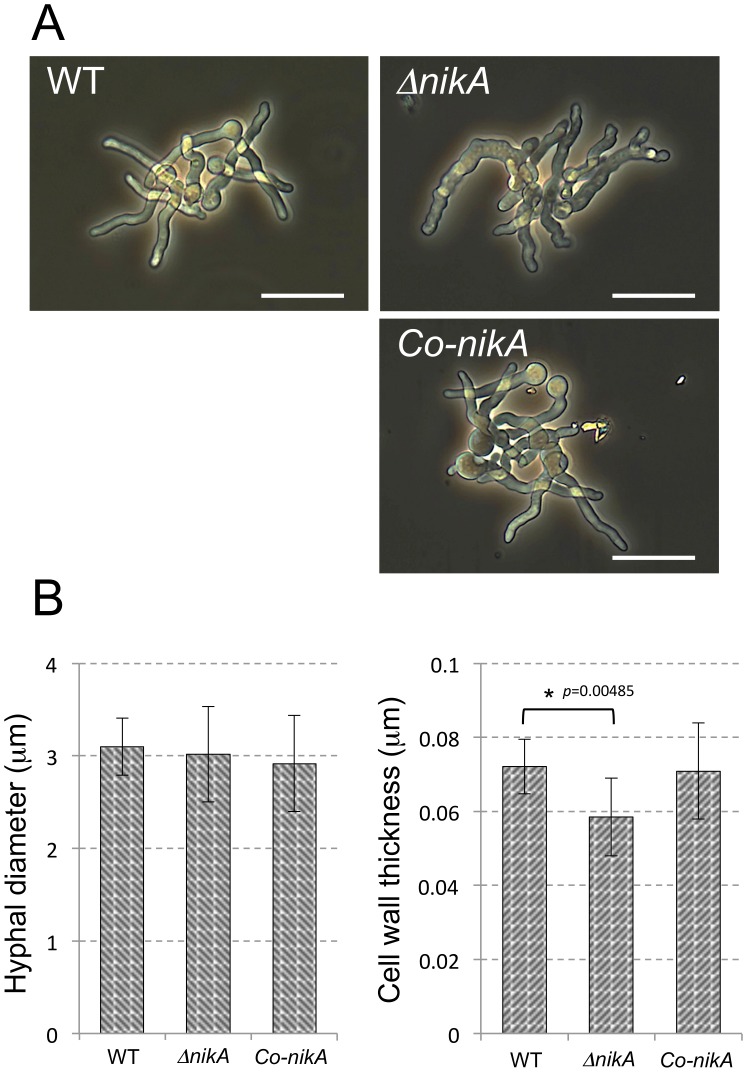
Defects of the cell wall structure in ΔnikA.(A) Conidia were incubated for 9 h in YGMM. The germlings were observed under optical microscopy. The bar represents 20 µm. (B) The cell wall thickness and the diameter of hyphae were examined from the hyphal cross-section. In each cross-section, the cell wall thickness was examined from at least 10 different positions. The largest and smallest measurements were eliminated, and the rest of values were averaged. The column indicates the mean value of the hyphal diameter (left) and cell wall thickness (right) from 10 different cross-sections (n = 10). Error bars represent the standard deviations. P-values versus WT were calculated by the Student’s t-test.